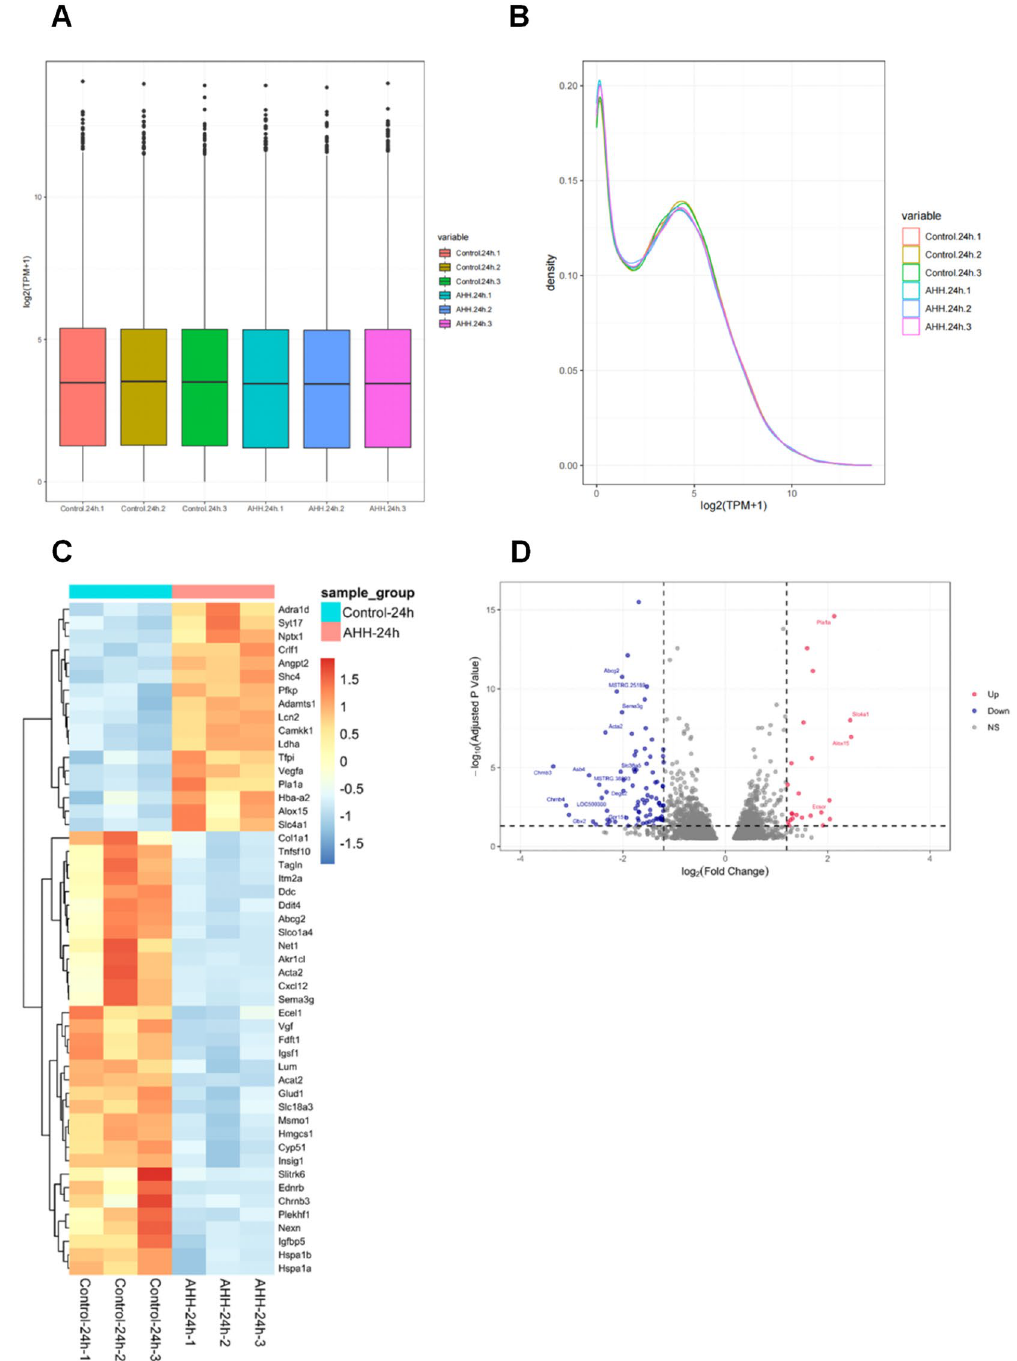
Figure 1. ( A ) Box plot of log 2 (TPM + 1) expression values for each sample. The horizontal coordinates in the plot represent the different samples; the vertical coordinates indicate the expression level of the sample log 2 (TPM + 1) values. The plot indicates the expression level of each sample in terms of the overall dispersion of expression. Box line plots for each region correspond to six statistical parameters (upper, outlier, upper quartile, median, lower quartile, and lower limit from top to bottom). ( B ) Density plot of the distribution of log 2 (TPM + 1) values for each sample. Different colored curves in the graph represent different samples; the horizontal coordinates of the points on the curves indicate the log values of TPM + 1 for the corresponding samples, and the vertical coordinates of the points indicate the probability density. ( C ) Heatmap analysis of 112 differentially expressed genes (DEGs) in the two groups: control-24 h and acute hypobaric hypoxia (AHH)-24 h groups. All genes shown are significantly differentially expressed between the two groups (adjusted p < 0.05). Colored bars from blue to red represent the increasing levels of gene expression from low to high. ( D ) Volcano plot analysis of 112 DEGs in the control-24 h and AHH-24 h groups. Each dot represents a gene that was detected in both groups. Red and blue dots indicate genes with significantly up and downregulated expression, respectively. Gray dots show genes that were not significantly differentially expressed between the control-24 h and AHH-24 h groups. The horizontal axis indicates the log ratio (changes in gene expression ploidy across samples), and the vertical axis indicates the probability of differential expression of each gene. The DEGs were identified using a false discovery rate of